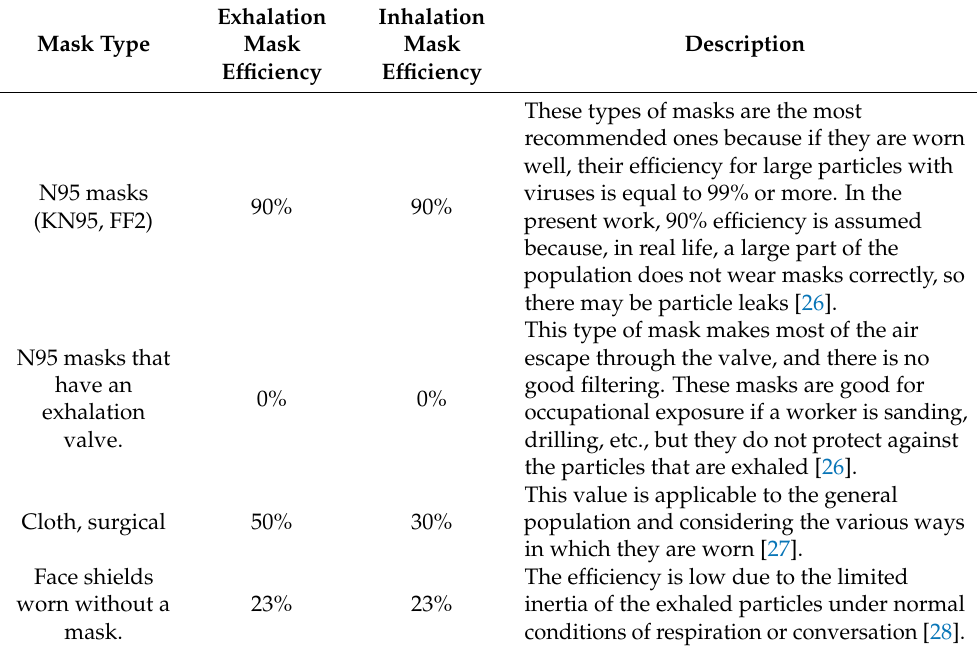
Table 3. Mask efficiency in reducing virus inhalation by a susceptible person.